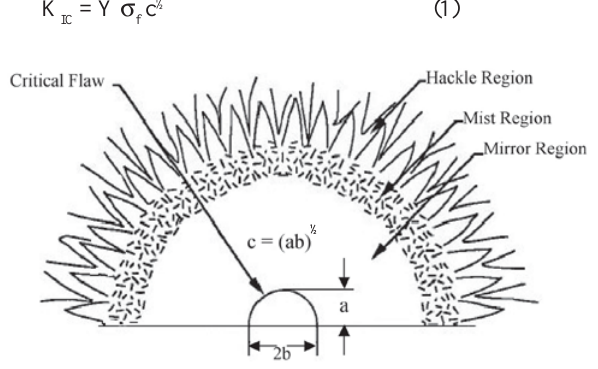
FIGURE 7- Diagram of the typical fracture surface features occurring in brittle materials. The regions are not drawn to scale